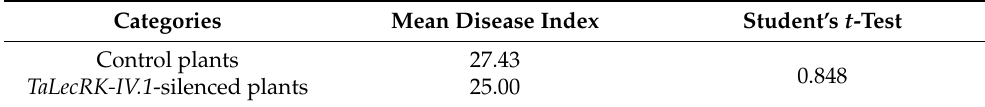
Table 1. Average disease index of control (BSMV:00 infected) and silenced (BSMV: TaLecRK-IV.1 infected) CI12633 plants and test of comparison of the two means by Student’s t -test.